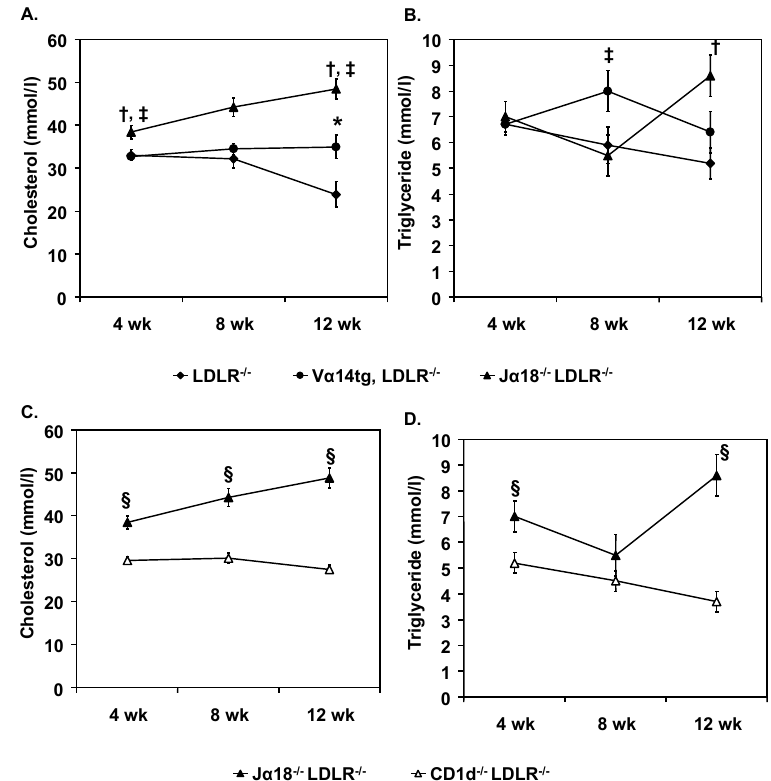
Figure 2. Plasma lipid levels. Plasma cholesterol ( A , C ) and triglyceride ( B , D ) in 4 h fasted plasma was measured every 4 weeks. Significance p < 0.005: * LDL receptor deficient (LDLR − / − ) vs. V α 14tg / LDLR − / − ; † LDLR − / − vs. J α 18 − / − LDLR − / − ; ‡ V α 14tg / LDLR − / − vs. J α 18 − / − LDLR − / − ; §CD1d − / − LDLR − / − vs. J α 18 − / − LDLR − / − . For 4 weeks: n = 21–45. For 8 weeks; n = 12–34. For 12 weeks; n =